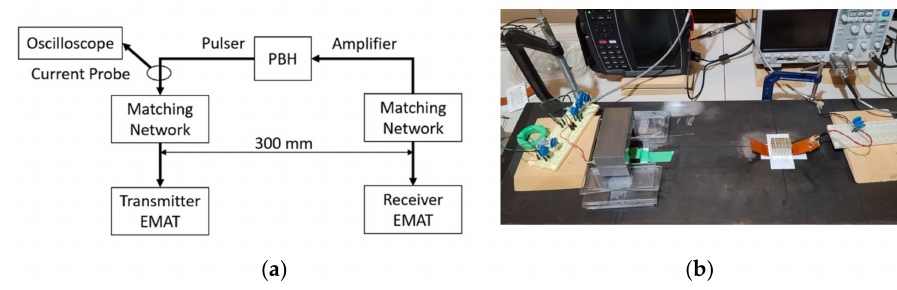
Figure 10. Typical Experimental Setup (MS-to-PPM shown) ( a ) Schematic; ( b ) Photograph.